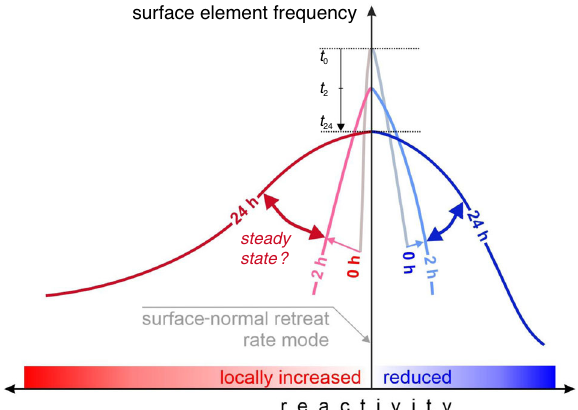
Fig. 8 Generalized depiction of the height evolution of the reacting surfaces during degradation. The height histogram is converted into a representation of surface reactivity. Locally excessive height loss (left, red) represents locally increased surface reactivity. Analogous is the representation on the right (blue). After an initial increase in the reactivity range, a steady state is probably reached after about 2 h, which is reported until 24 h of